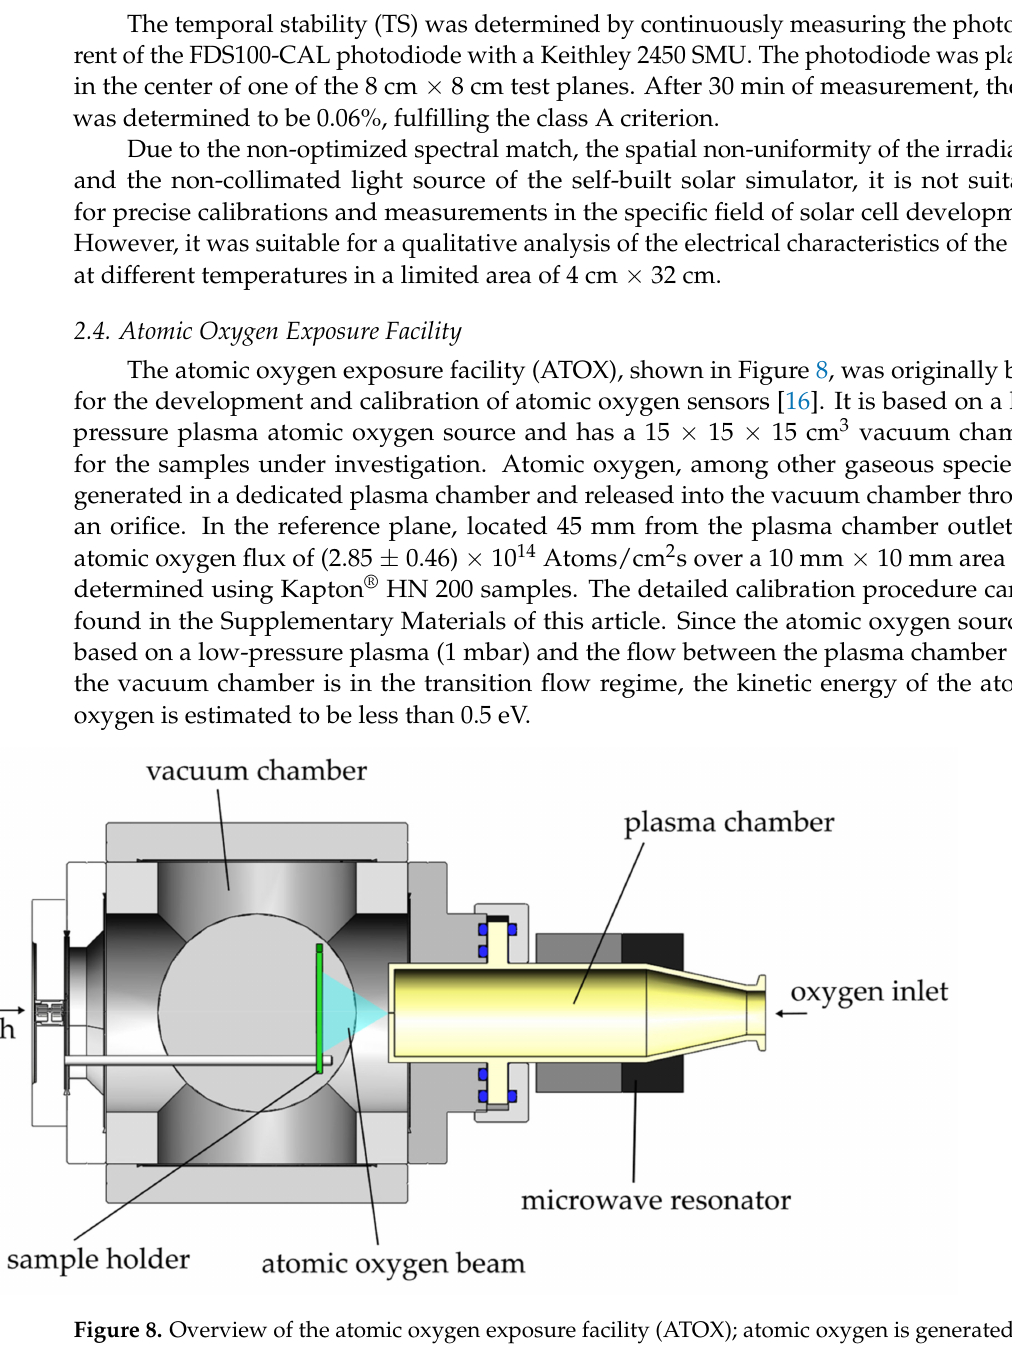
Figure 8. Overview of the atomic oxygen exposure facility (ATOX); atomic oxygen is generated in a microwave-based low-pressure oxygen plasma and released into a vacuum chamber, creating a flow of atomic oxygen and other gaseous species to a